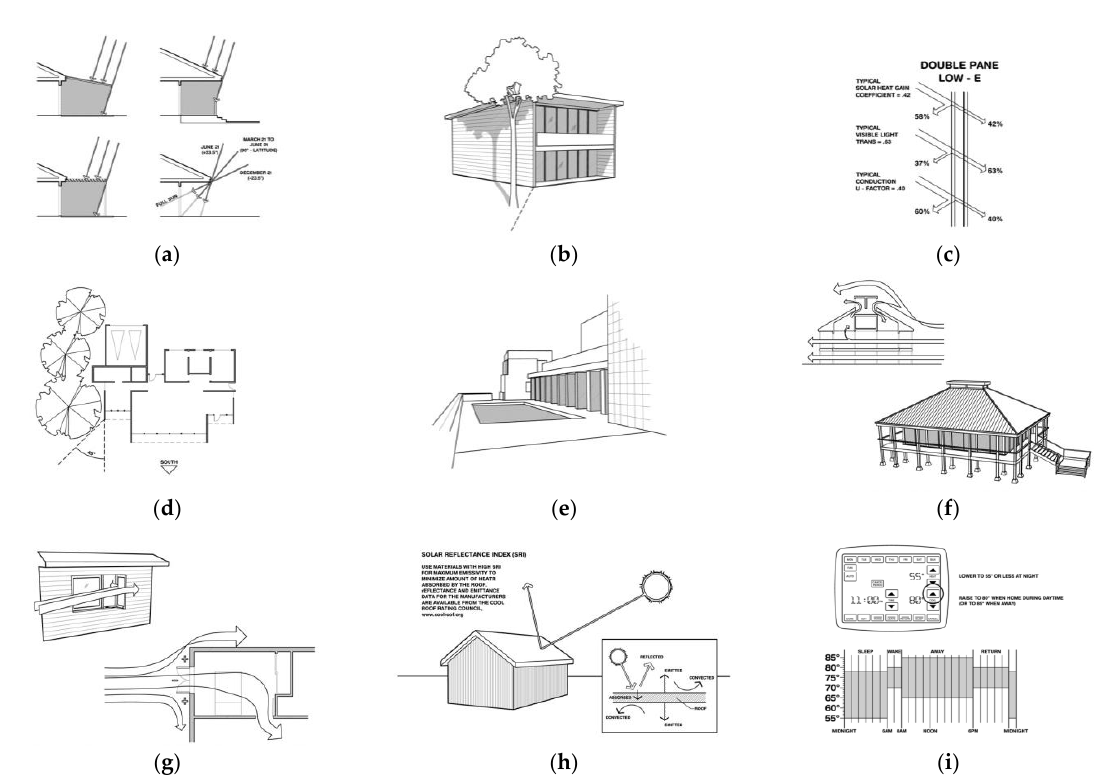
Figure 7. Recommended bioclimatic strategies: ( a ) Windows with operable overhangs or sunshades, ( b ) Minimization or elimination of glazing on west-facing façades, ( c ) High-performance glazing (insulated frames and low emissivity), ( d ) Use of plants and trees in the west orientation to minimize heat gain, ( e ) Orient most glazing to the north (using vertical fins) ( f ) Elevating the building above the ground to minimize humidity and maximize natural ventilation under the floor and roof with openings for ventilation ( g ) Shaded windows facing the prevailing breeze to promote natural ventila- tion, ( h ) Use of materials with light colors and ceilings with high emissivity ( i ) Increase in thermostat setting temperature.